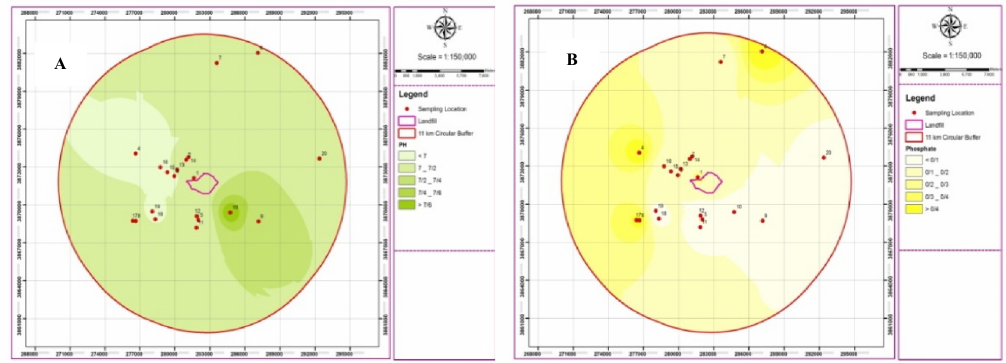
Fig. 4. Spatial Variation of (A) pH, (B) PO 4 in groundwater resources in the study area